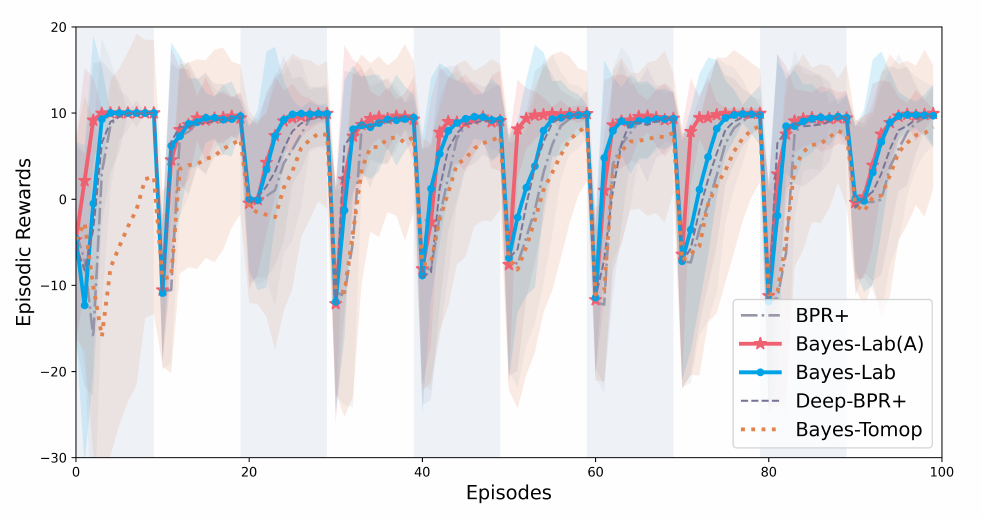
Figure 8. The episodic rewards for 100 episodes of